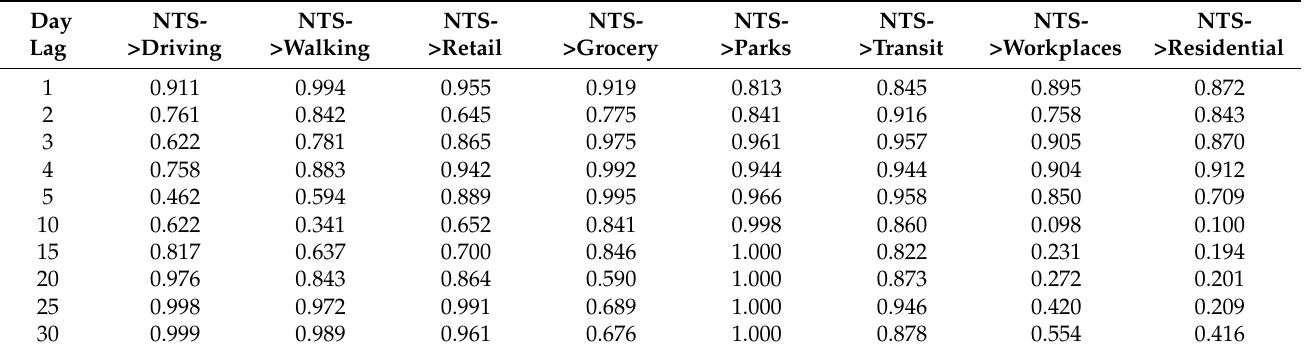
Table A6. New_tests_smoothed (NTS), Granger-cause mobility variables, and p -values in day lags in